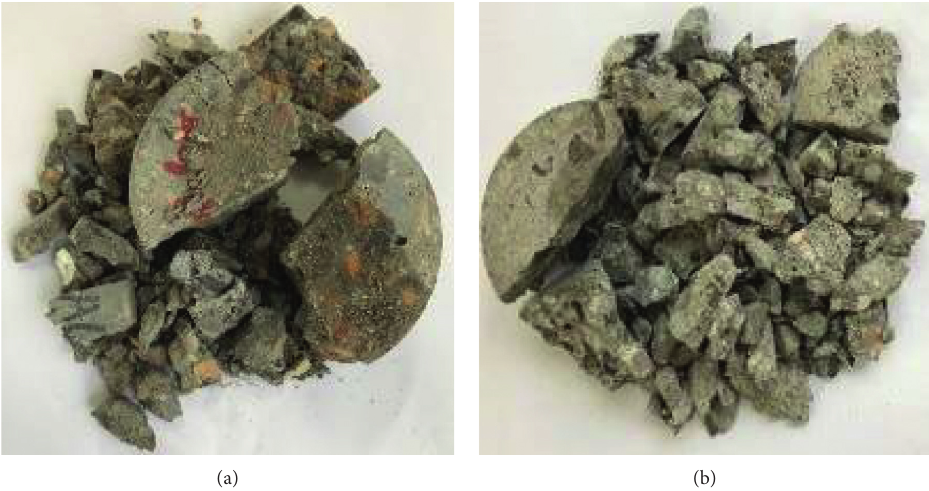
Figure 18: N-SFC and N-SAC after crushing. (a) N-SFC. (b)